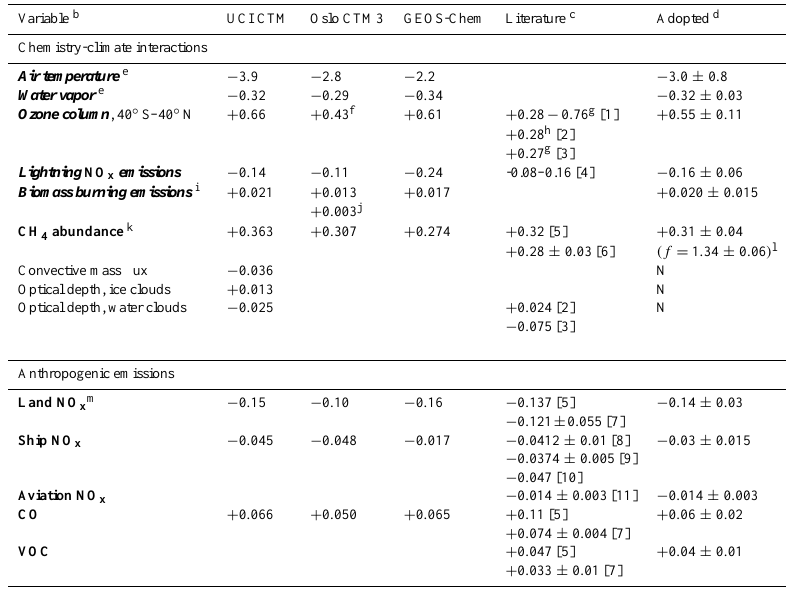
to climate variables and emissions a 4 × OH